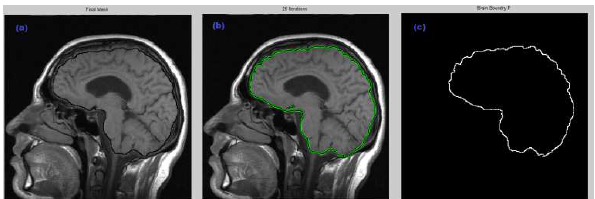
Fig.4 (a) Initial Brain Mask, (b) Final Brain Mask, (c) Brain